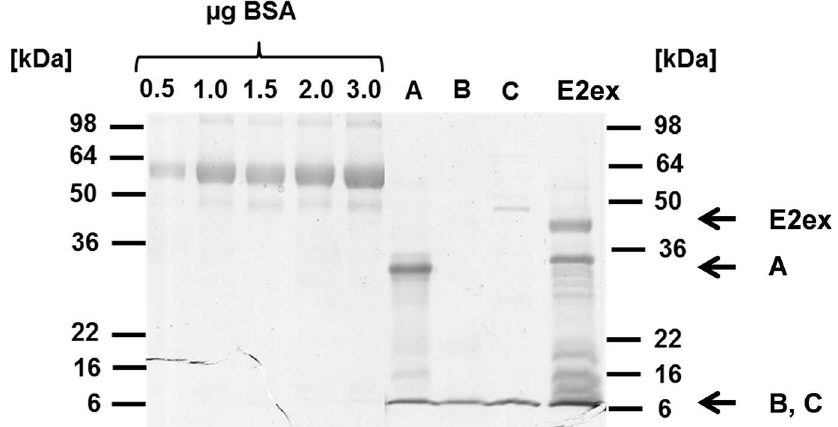
Fig 4. Purificationof recombinantCHIKV E2 domainsA, B, and C, and E2ex. The CHIKV E2 domainsA, B, and C, and E2ex were cloned into the pET-15b vector, and the proteins were expressedin E . coli and purified under native (B, C) or denaturingconditions (A, E2) by HPLC (Ni-NTA beads). For A and E2, ion-exchange chromatography was additionallyperformed after the HPLC. Subsequently, they were dialyzedagainstPBS and concentrated. Shown is an SDS-PAGE with subsequent Coomassie stainingof the purifiedproteins. BSA dilutionswere used to estimate the protein concentration. Domain A has a molecularmass of 26.5 kDa, B of 8.5 kDa, C of 10.7 kDa, and E2ex of 40.4